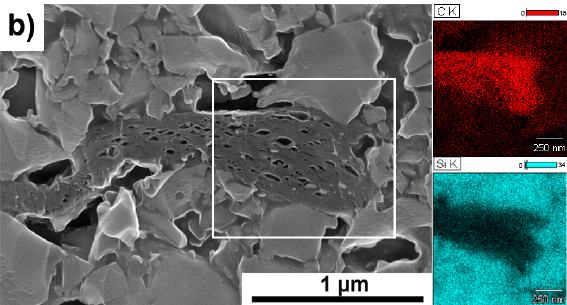
Figure 5. Morphology of SiC–C–B–Ti 3 C 2 powders annealed in vacuum ( a ) at 1400 °C, ( b ) at 1600 °C. The disordered carbon structure particles did not show such porosity. This may indicate that the formation of porous particles is a transitional stage in the formation of disordered carbon structures. As in the case of annealed pure MXene, the bandgap value was determined for the identification of oxides on the MXene surface (Figure 6).